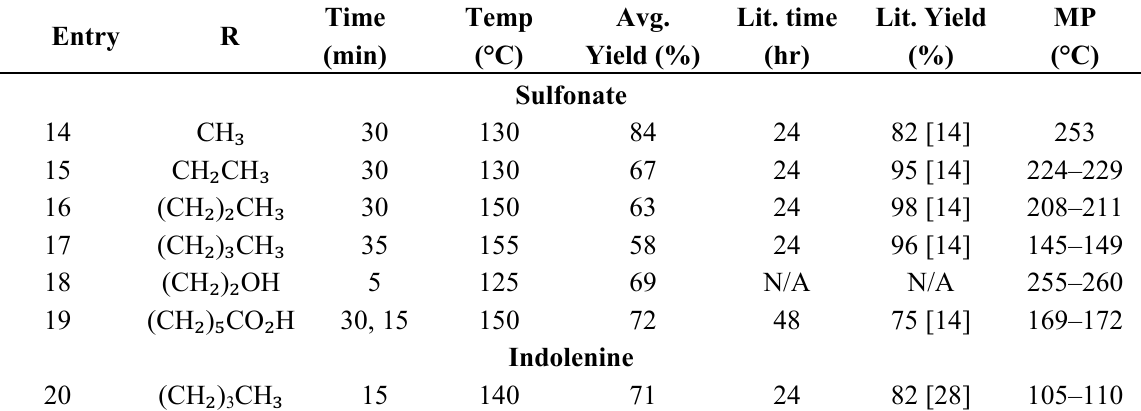
Table 3. Synthesis of trimethyl-5-sulfo-3 H -indolium derivatives (Discover SP CEM).